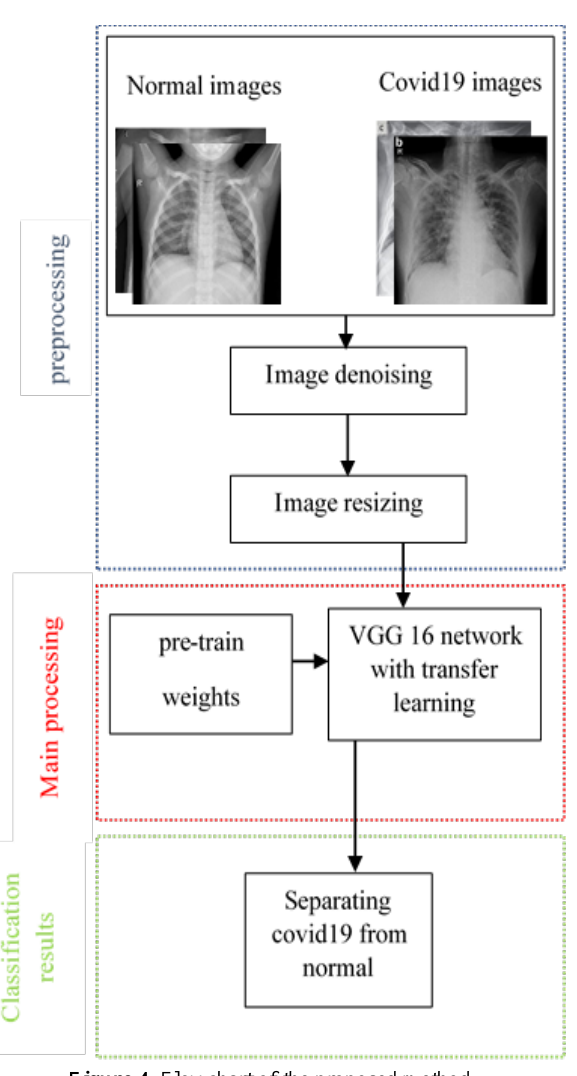
Figure 4 . Flowchart of the proposed method.